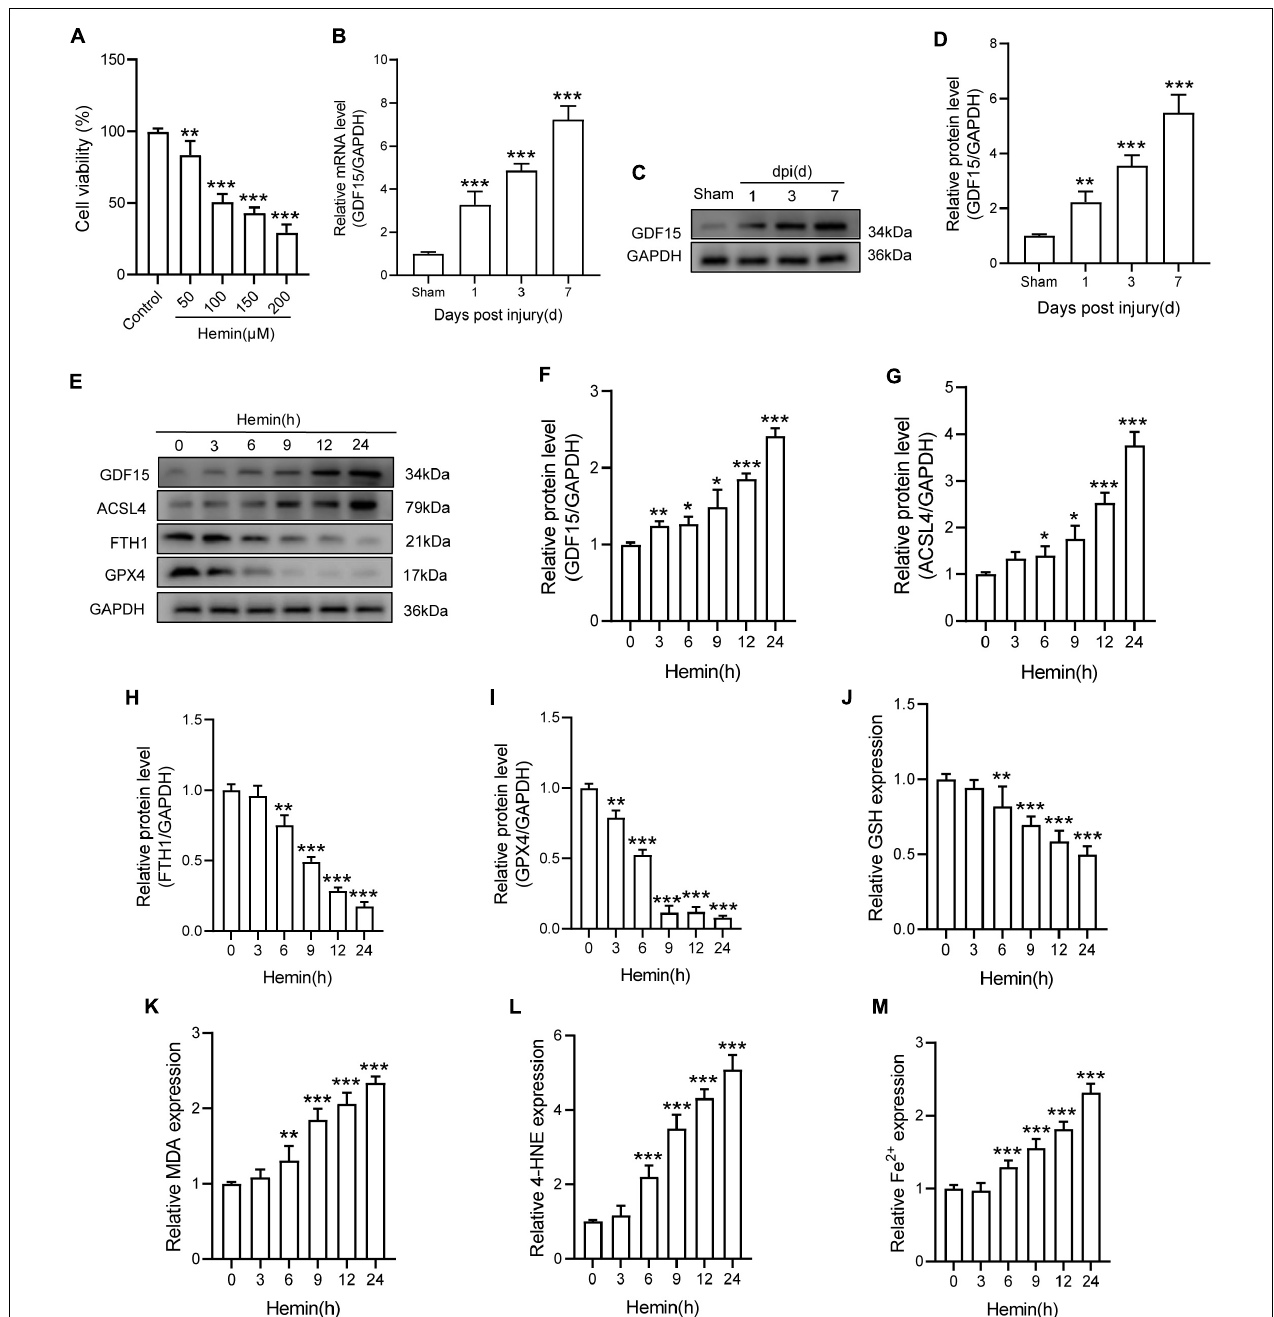
FIGURE 1 | GDF15 was increased in SCI and neuronal ferroptosis. (A) Cell viability was detected by CCK-8 ( n = 6). (B) Relative mRNA level of GDF15 in the spinal cord within a week post-injury ( n = 6). (C) Western blotting of GDF15 protein levels in the spinal cord within a week post-injury ( n = 6). (D) Bar graph showing a quantitative analysis of GDF15 expression ( n = 6). (E) Western blotting of GDF15 and ferroptosis-associated proteins including ACSL4, FTH1, and GPX4 in Hemin-stimulated primary neurons within 24 h ( n = 3). GAPDH was used as the control. (F–I) Bar graph showing quantitative analysis of GDF15, ACSL4, FTH1, and GPX4 ( n = 3). (J–M) The values of GSH, MDA, 4-HNE, and Fe 2 + concentrations were determined; n = 6. The error bars represent the SD. * p < 0.05 vs. control group by one-way ANOVA followed by Tukey’s post hoc analysis (* p < 0.05, ** p < 0.01, and *** p < 0.001). Sham: Only laminectomy was performed.